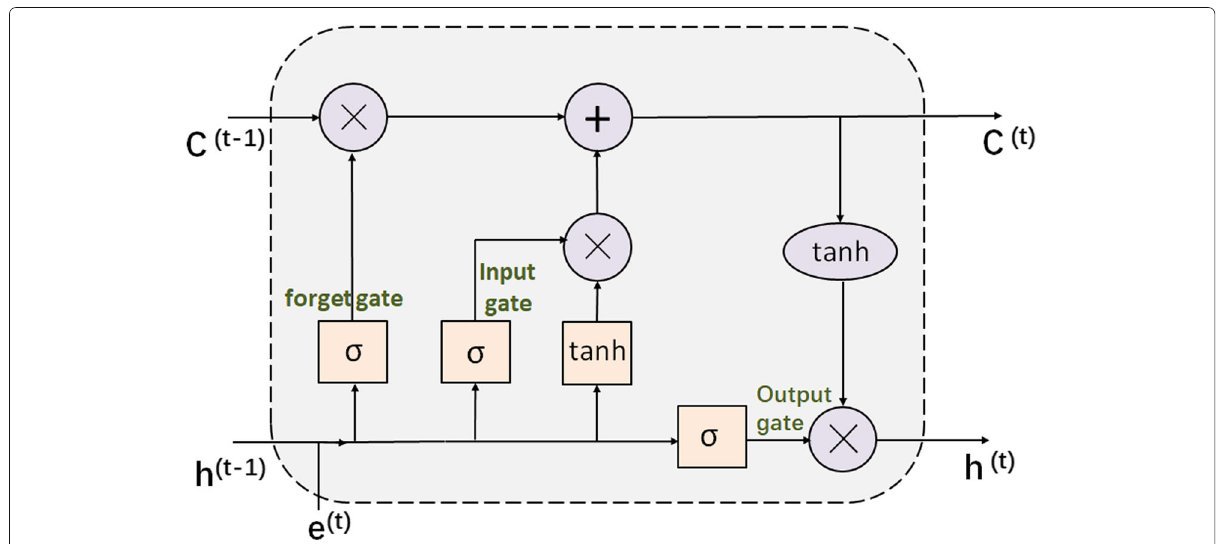
Fig. 3 Structure of the LSTM cell